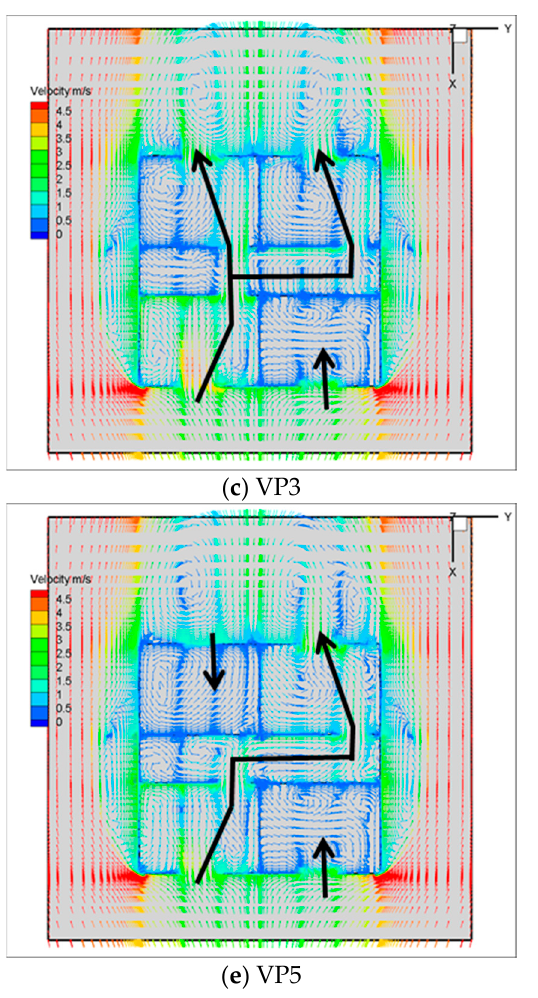
Figure 8. The velocity distribution at the z = 1.2 m cross-section with a 10% windward wall porosity. ( a ) VP1; ( b ) VP2; ( c ) VP3; ( d ) VP4; ( e )